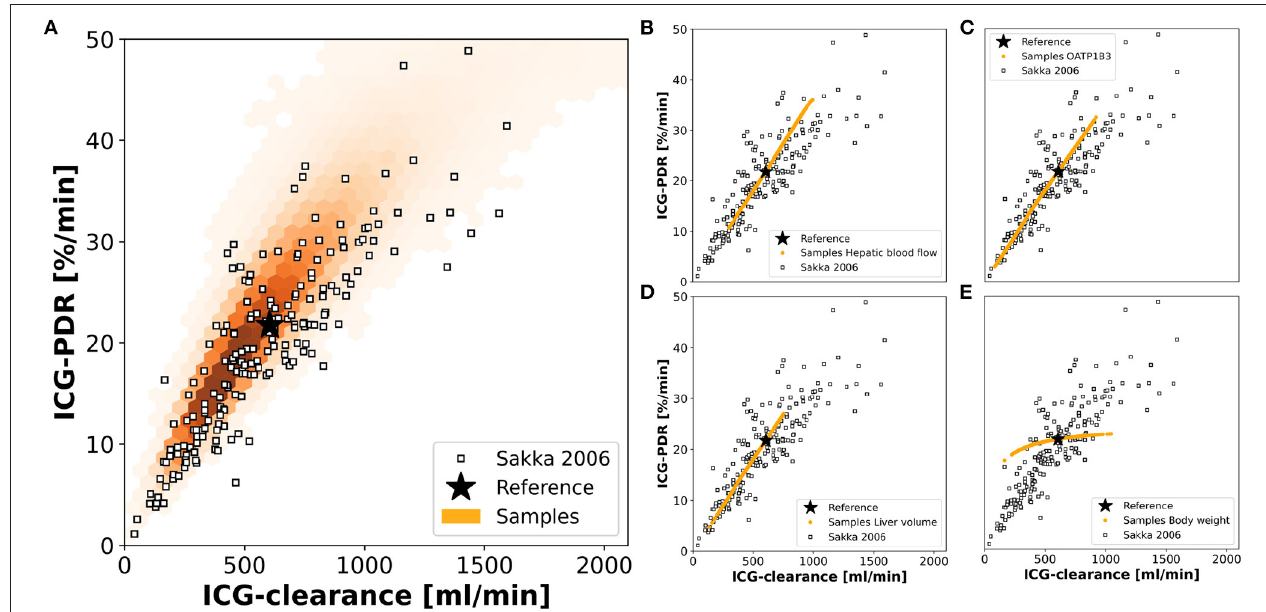
FIGURE 9 | Contributions to population variability: Relationship between ICG-clearance and ICG-PDR with clinical data from Sakka and van Hout (Sakka and van Hout, 2006 ). (A) Results of the simulations of the complete in silico population ( n = 100,000). (B–E) Results of simulations, when hepatic blood flow, OATP1B3 level, liver volume, or body weight were varied individually in the range covered by the population. The respective other factors were set to their respective reference values in the simulation. Stars depict the reference simulation of the